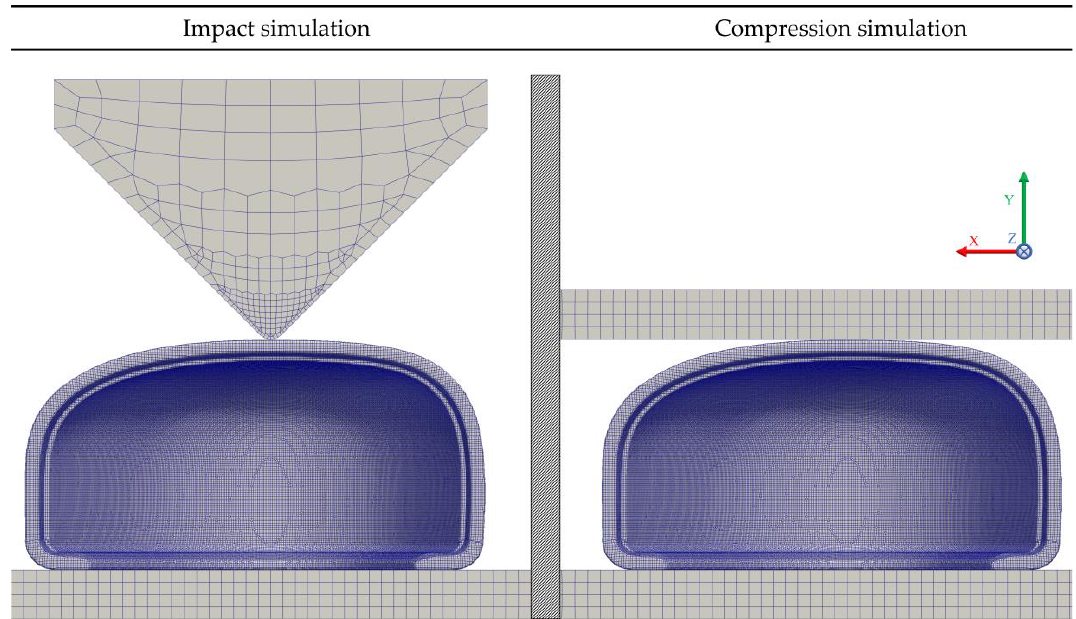
Figure 7. Back view, M4 and plates mesh for the impact and the compression simulation